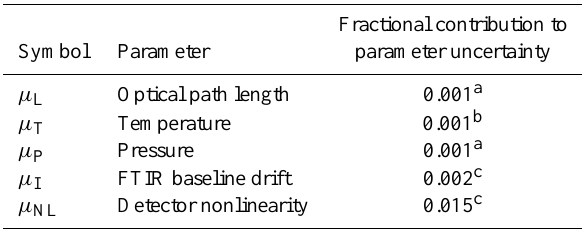
Table 3. Sources of systematic uncertainties and estimated contri- bution to the total uncertainty.